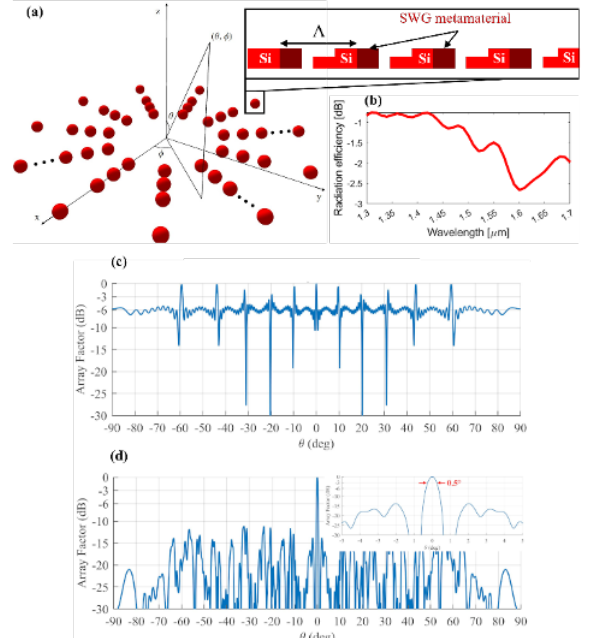
Fig. 1. (a) Schematics of circular array with silicon antennas. Inset: 2D schematics of the L -shaped grating antenna. (b) Antenna radiation efficiency versus wavelength. Elevation cut of array factor amplitudes for (c) M = 4 and (d) M = 11.